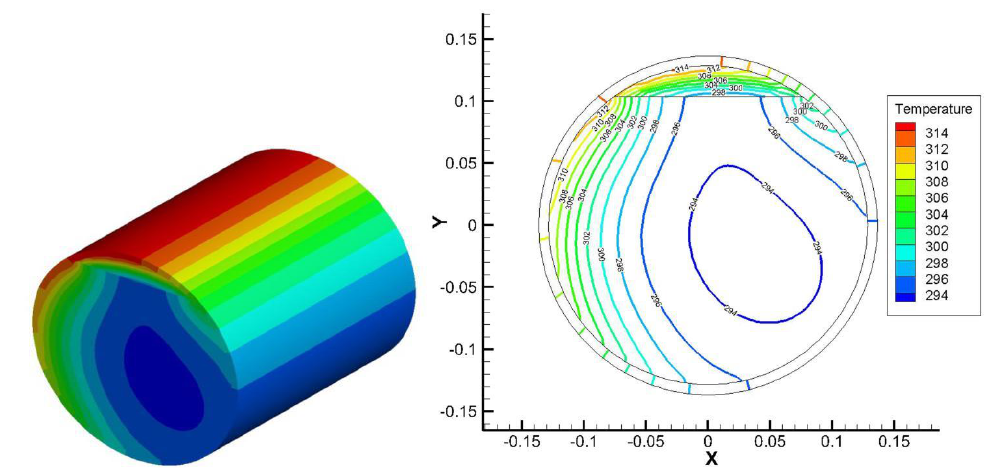
Figure 7. Temperature cloudy map and isopleth at 60° (unit: K).